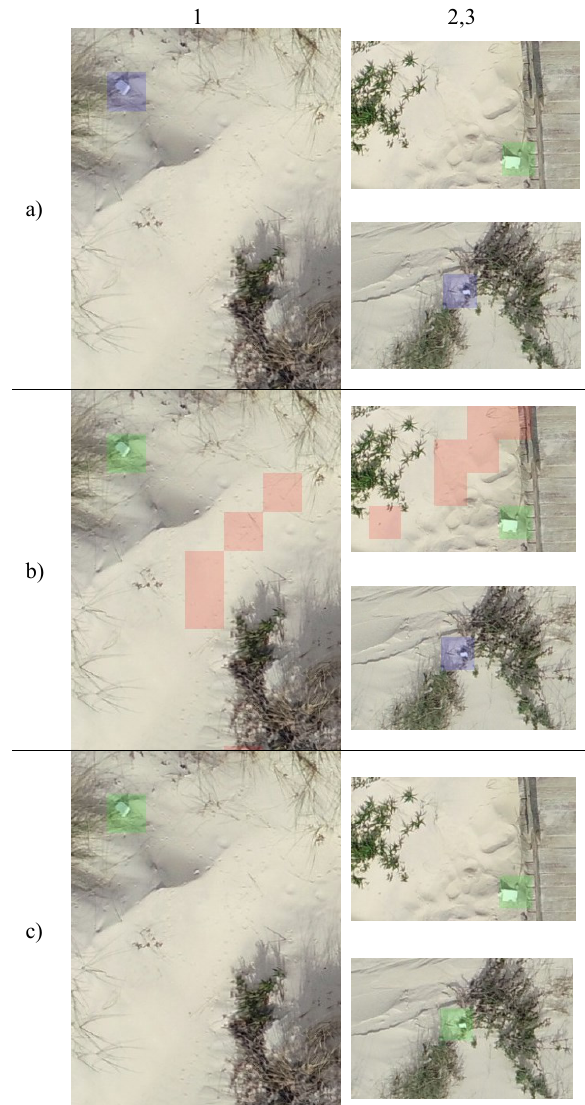
Figure 5. Details of the results for the dunes. Blue tiles are false negatives, red tiles false positives and green tiles true positives.